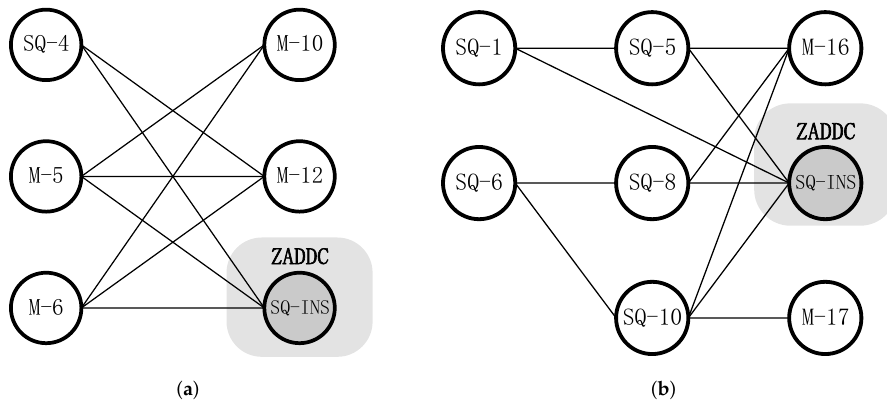
Figure 5. Directed acyclic graph of improved ZADDU and DBLU (A and S omitted). ( a ) DAG of ZADDU. ( b ) DAG of